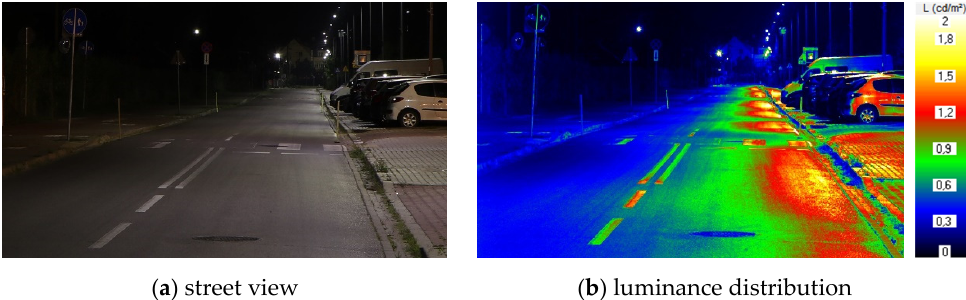
Figure 17. View of the street with lighting when the luminous flux Φ of the lamps is controlled to 100% (average luminance of the roadway is Lav = 0.75 cd/m 2 ).